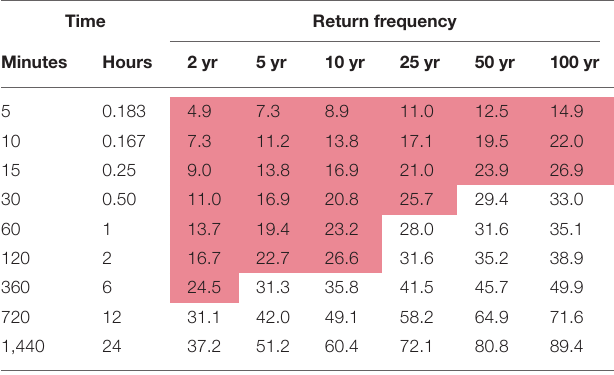
TABLE 2 | Potential efficiency of rain gardens in Calgary (adapted from City of Calgary, 2011).